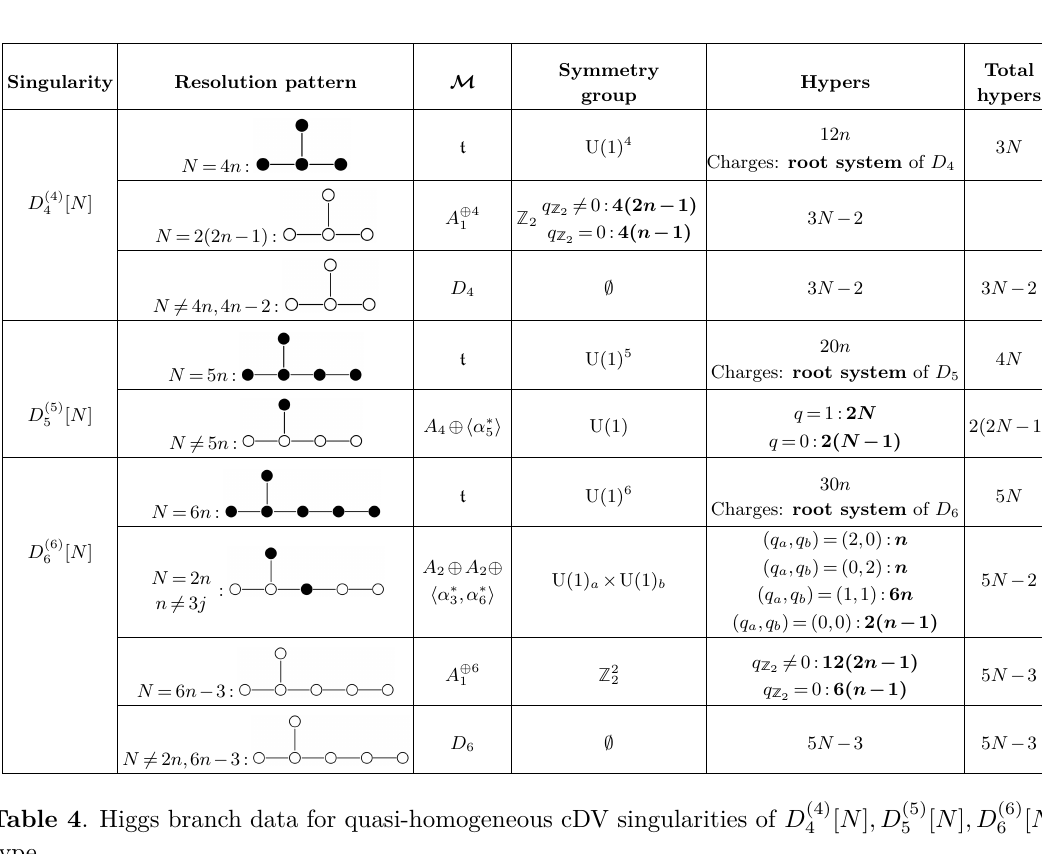
Table 4 . Higgs branch data for quasi-homogeneous cDV singularities of D (4) type.